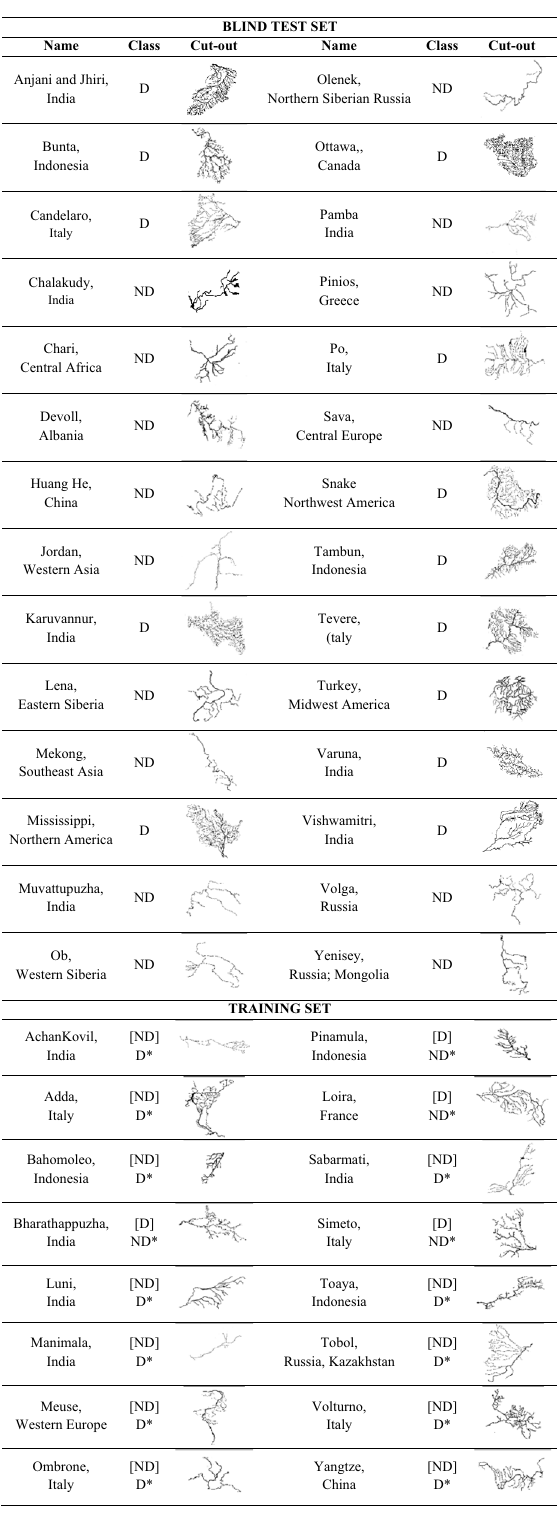
Table 2. Upper part: list of drainage networks composing the blind test set used in the experiments, where D is dendritic, ND non-dendritic; lower part: list of training drainage networks with the first-class assignment (the class between square brackets), used in the Qualitative test (Q-test) and robustness test (Rob-test) experiments. The class marked with an asterisk indicates a different class assignment as changed in the training set for the reliability test